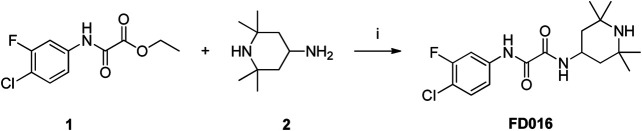
Synthesis of FD016. Reagents and conditions: (i) Et3N, Toluene, MW, 150°C, 3 h.